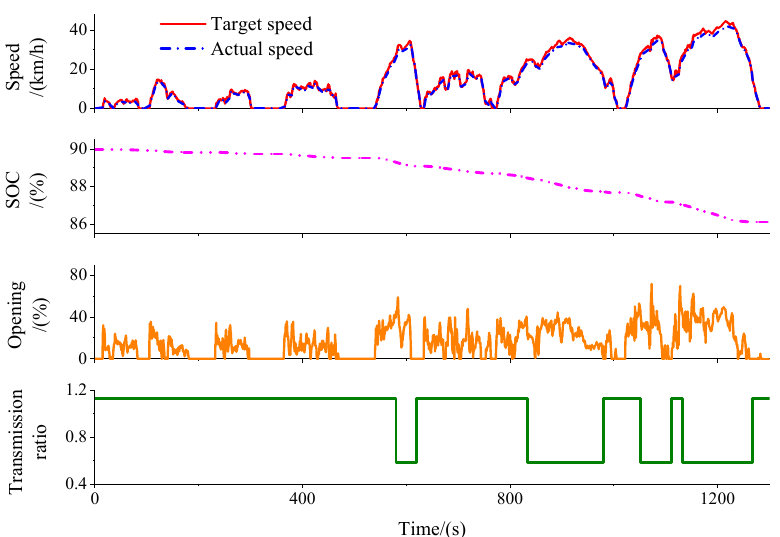
Figure 25. The simulation results of the energy consumption of the optimal economic shift rule.